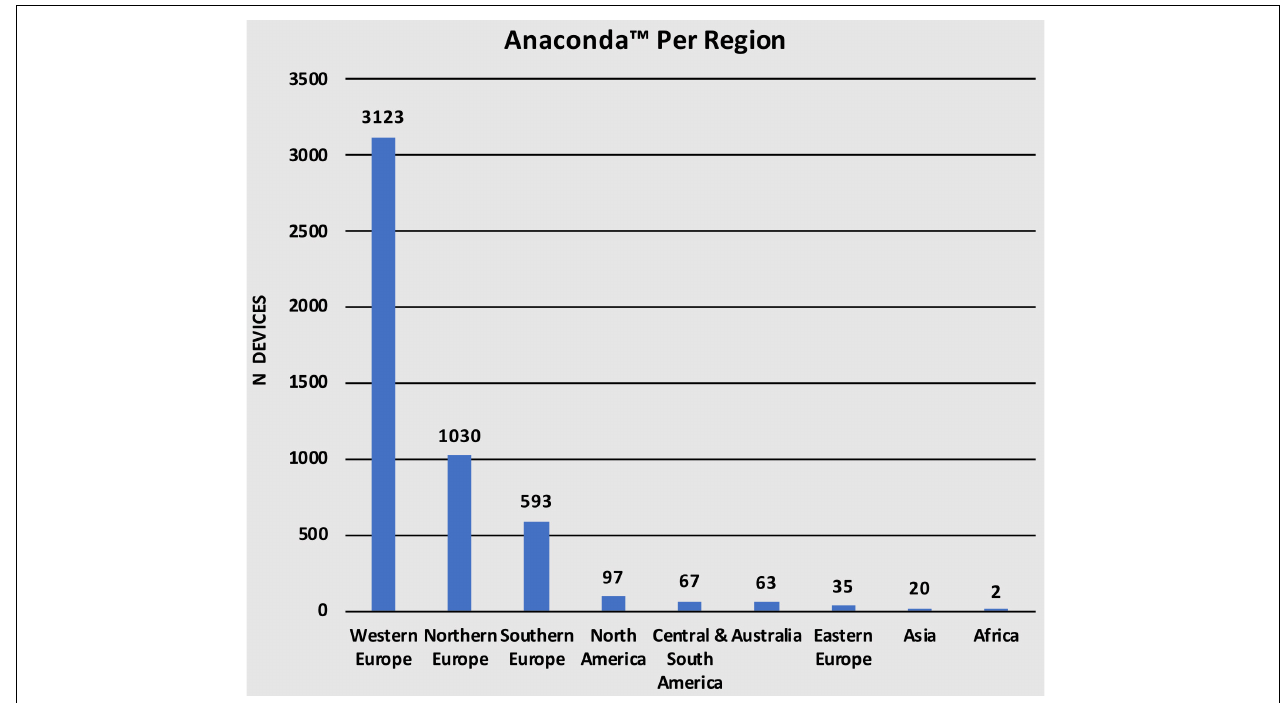
FIGURE 2 | Geographical distribution of AnacondaTM utilization.